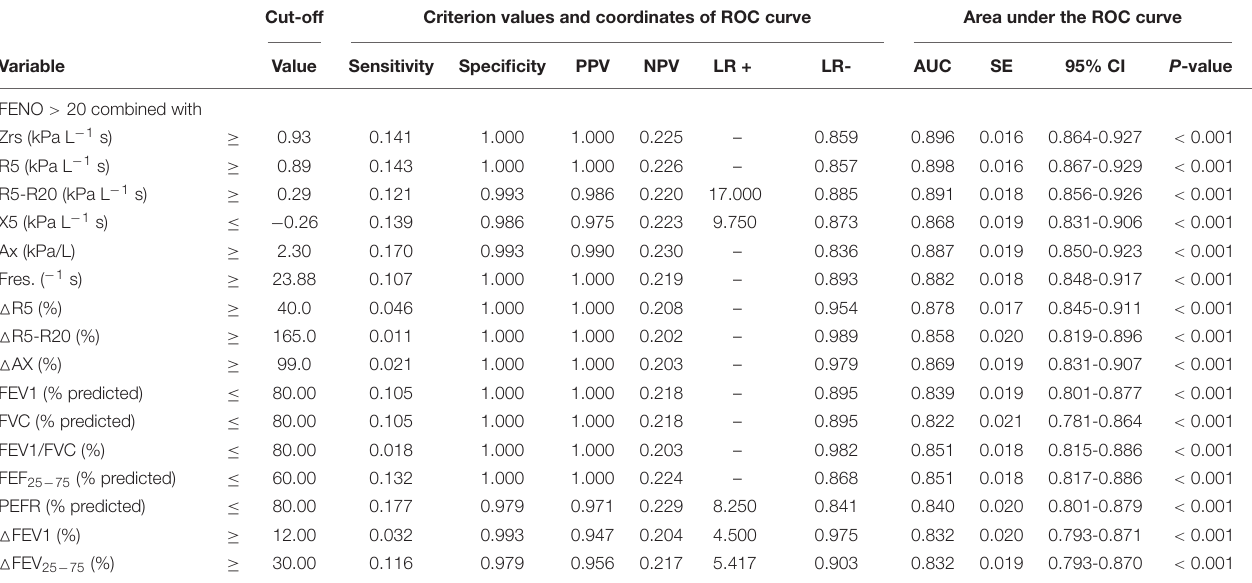
TABLE 3 | Predictive values of FENO ( > 20 ppb) combined with IOS and spirometry measurements for asthma diagnosis. Cut-off Criterion values and coordinates of ROC curve Area under the ROC curve